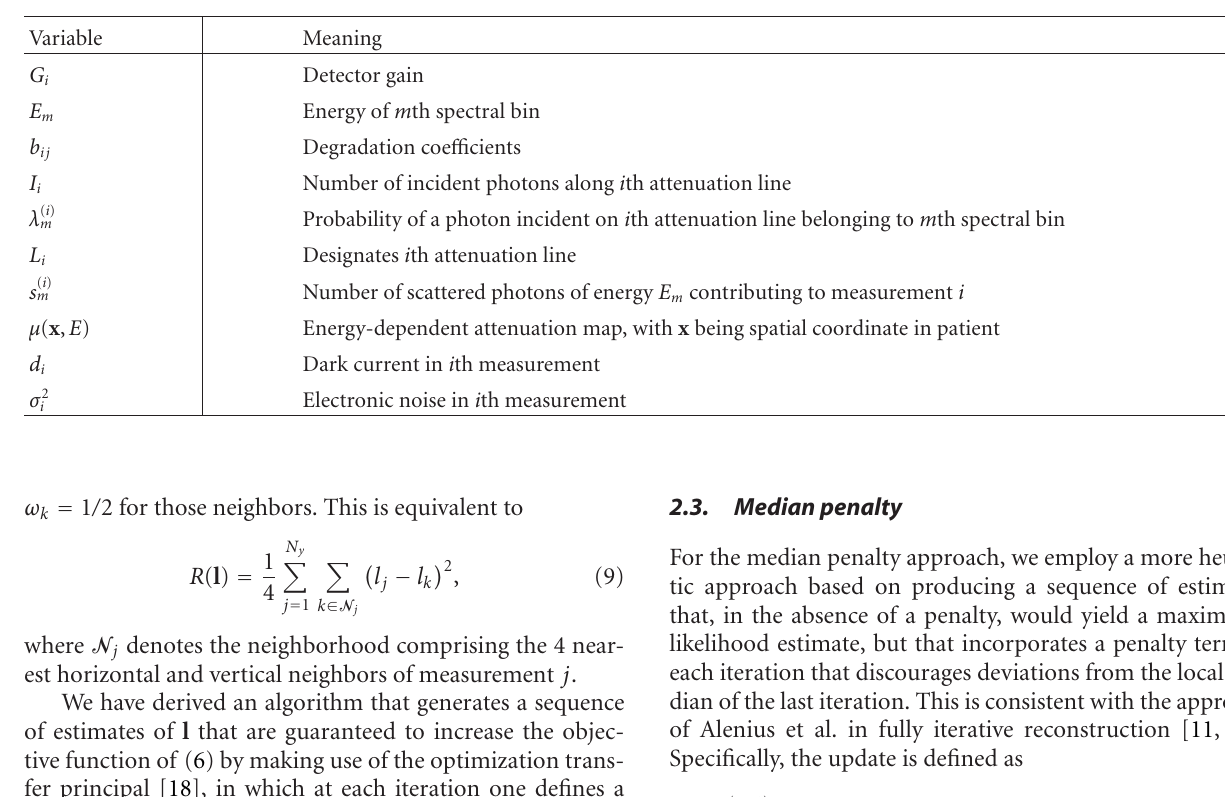
Table 1: Definition of terms in